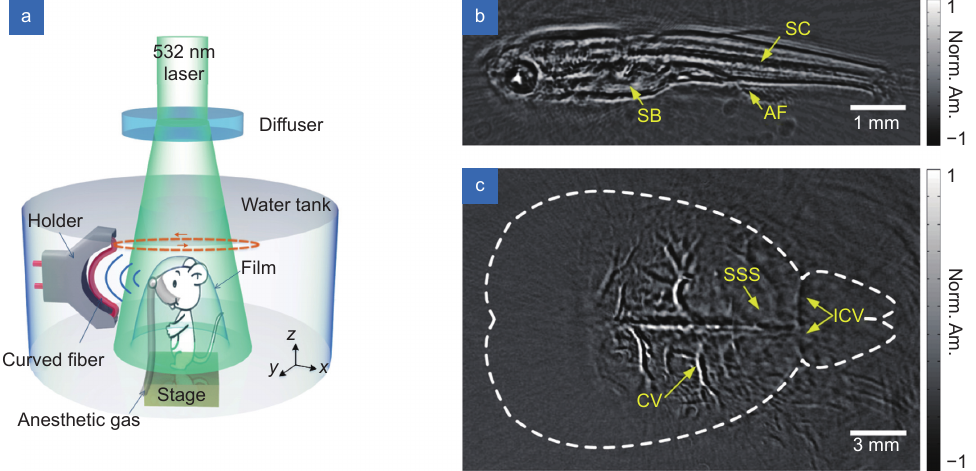
Fig. 7 | ( a ) Schematic of a rotary-scanning PACT with the fiber laser sensor. Photoacoustic images of ( b ) a zebrafish and ( c ) a mouse brain. SB: swim bladder; SC: spinal cord; AF: anal fin; CV: cortical vessels; SSS: superior sagittal sinus; ICV: inferior cerebral vein. Figure reproduced with permission from ref. 29 , Optical Society of